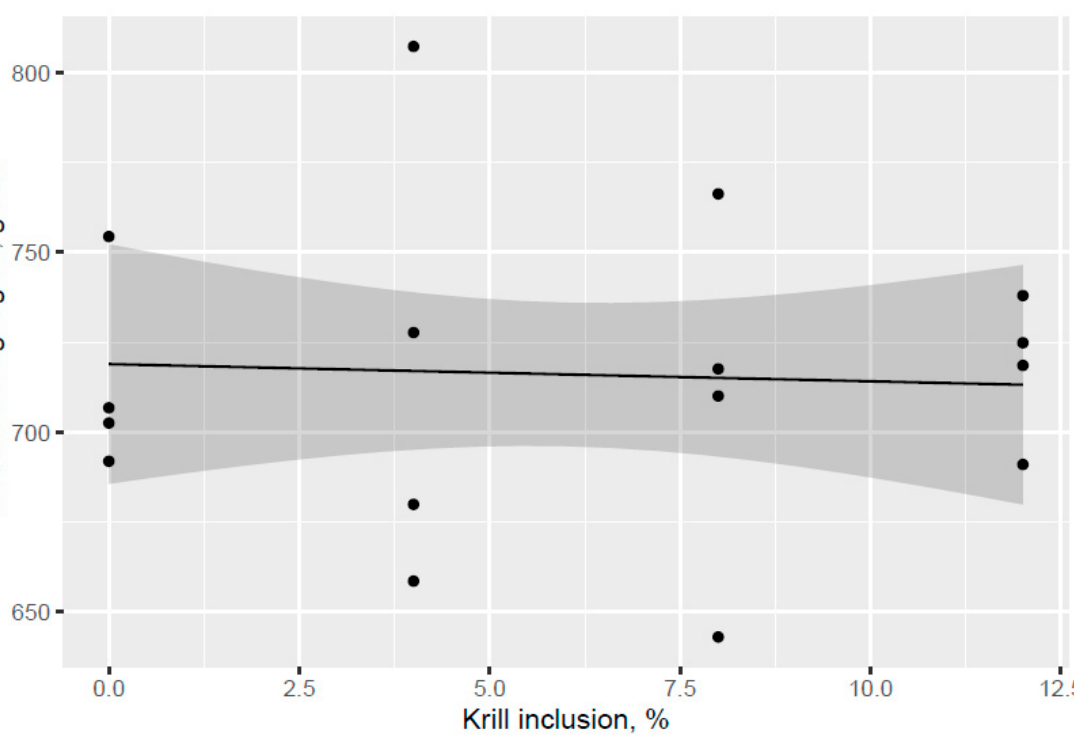
Figure 4. Modelled weight gain with increasing KM inclusion over 53 d in the freshwater pre-transfer phase followed by feeding the same commercial diet over 98 d in the common seawater tank plotted with 95% credible intervals as the grey band. Dots denote observed tank mean weight gains.